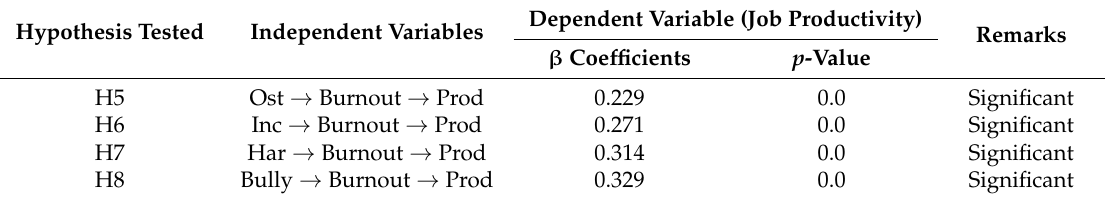
Table 6. Results of Indirect